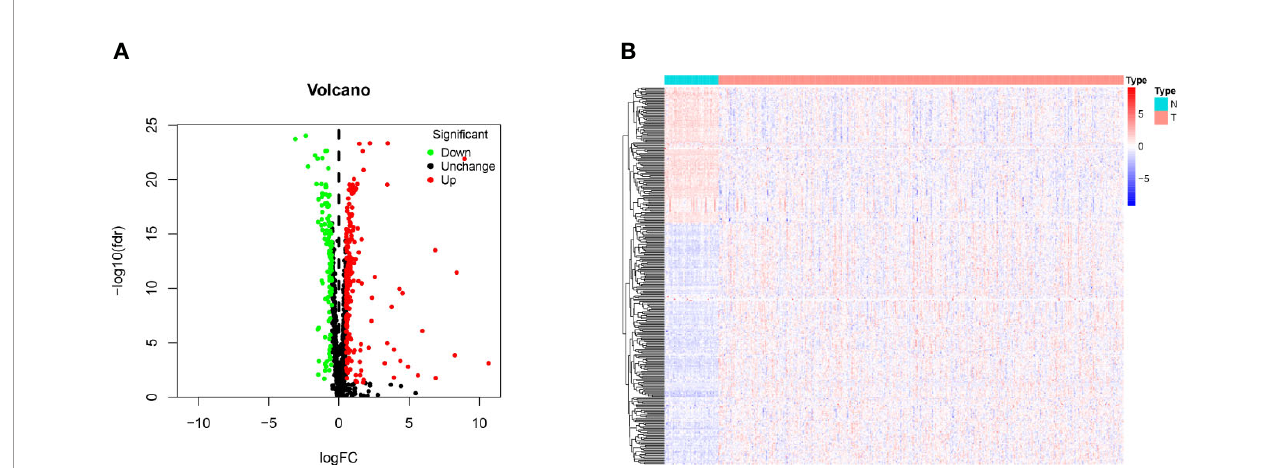
FIGURE 1 | Identi fi cation of differentially expressed RNA binding proteins (DE RBPs) in TCGA dataset and enrichment analysis. (A) Volcano plot of all DE RBPs between HCC and normal samples, 208 were up-regulated and 122 were down-regulated. Red: up-regulated RBPs; Black: unchanged RBPs; Green: down- regulated RBPs. (B) Heat map of the DE RBPs based on their expression data log2 transformed FPKM values. The red represents high expression, and the green represents low